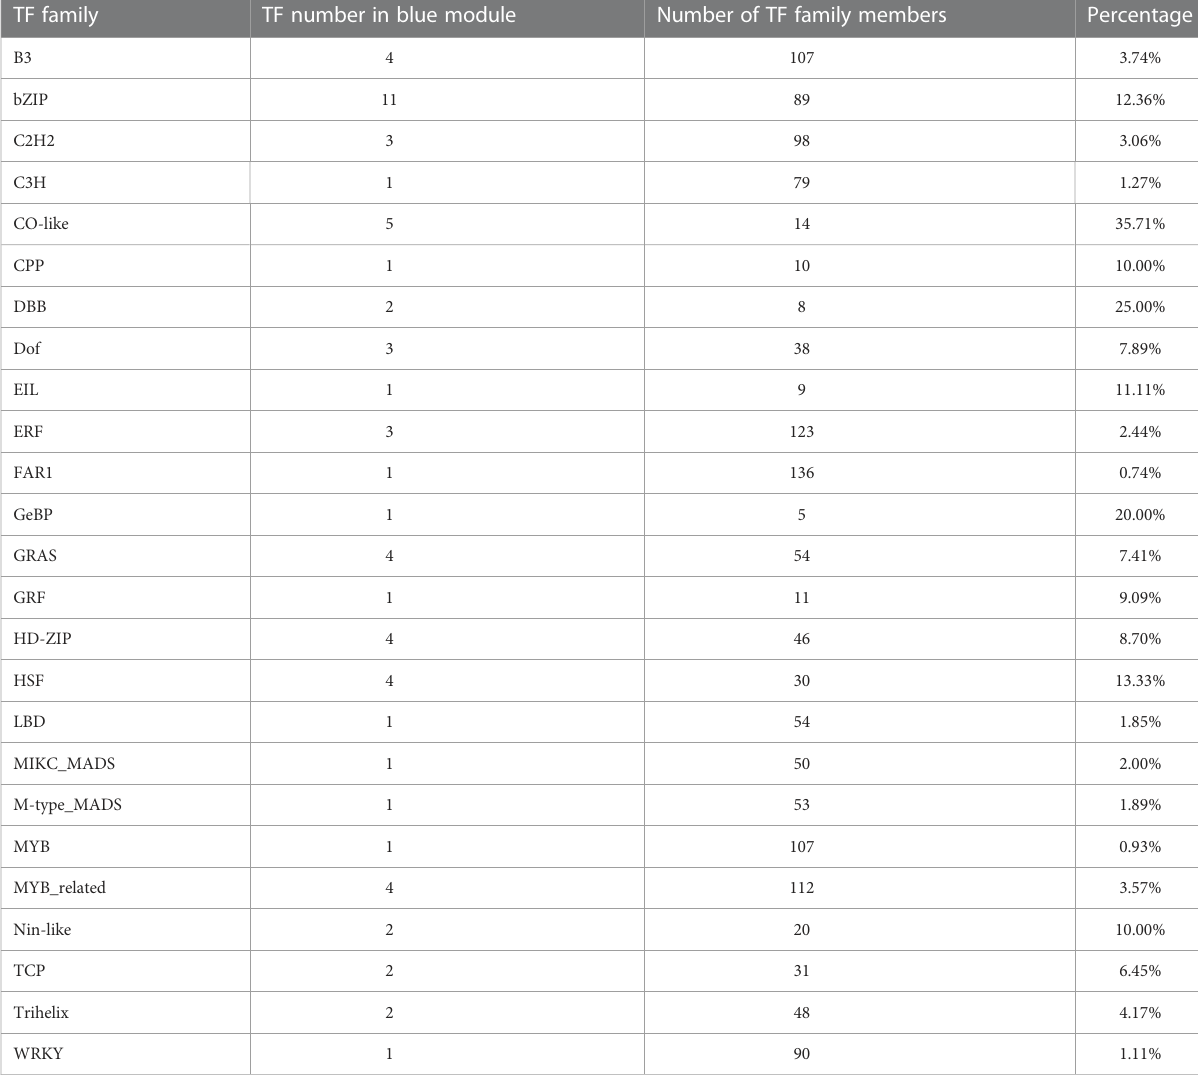
TABLE 2 The transcription factors co-expressed with CqFTL5 and CqFTL8 in blue module. TF family TF number in blue